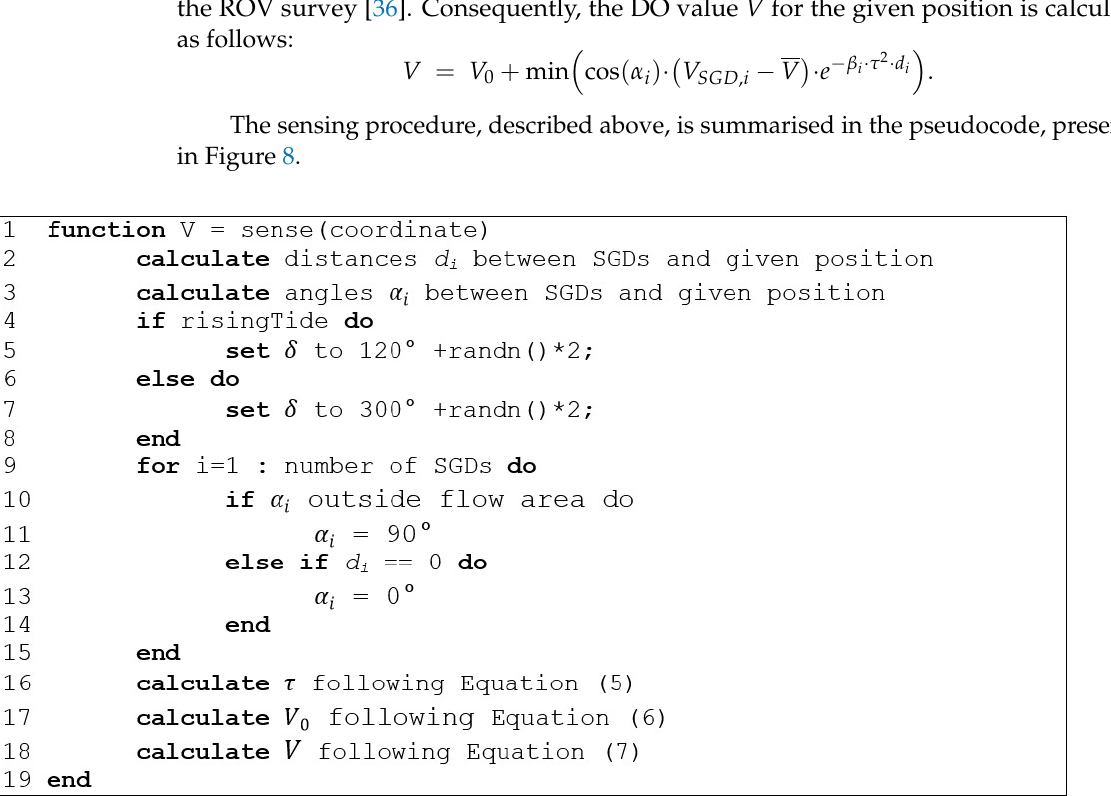
Figure 8. Pseudocode for sensing the simulated environment.